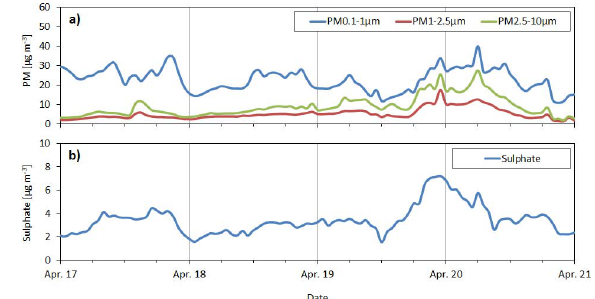
Fig. 11. Time series of additional parameters (hourly mean data) measured at Augsburg (AUHS) (17 April to 20 April) for (a) par- ticle mass concentrations (PM 0 . 1 − 1 , PM 1 − 2 . 5 and PM 2 . 5 − 10 ) and (b) sulphate mass concentration in PM 2 . 5 . A volcanic plume in- fluence is visible from the afternoon of 19 April until the morning of 20 April by significant increased concentrations of sulphate and coarse particles (PM 1 − 2 . 5 and PM 2 . 5 − 10 )